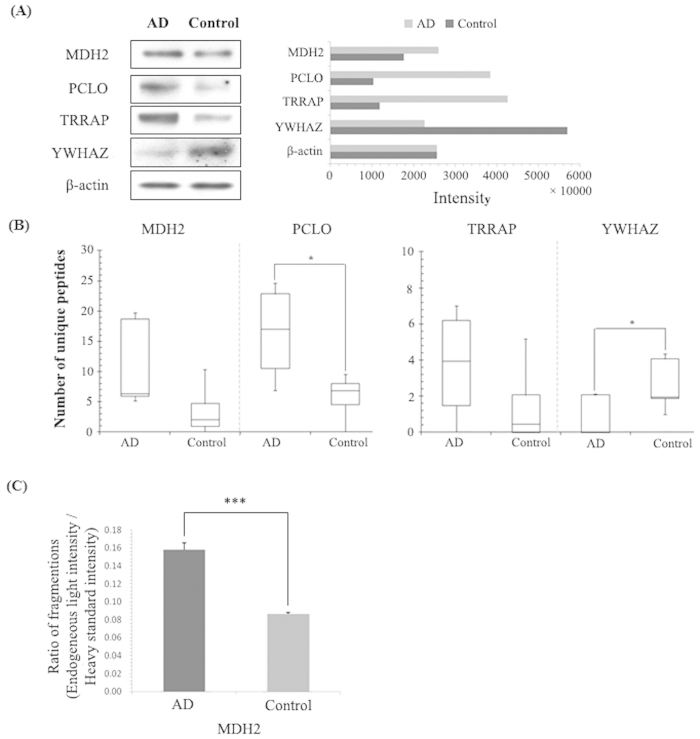
Validation of proteins identified by nanoLC coupled with ESI ion-trap MS.(A) Western blot analysis of MDH2, PCLO, TRRAP, and YWHAZ. (B) Spectral counting of PCLO, TRRAP, and YWHAZ. (C) Comparison of individual protein amounts with the fragmentation ratio (endogenous light peak area/heavy standard peak area) in AD and control tissues as assessed by SRM.